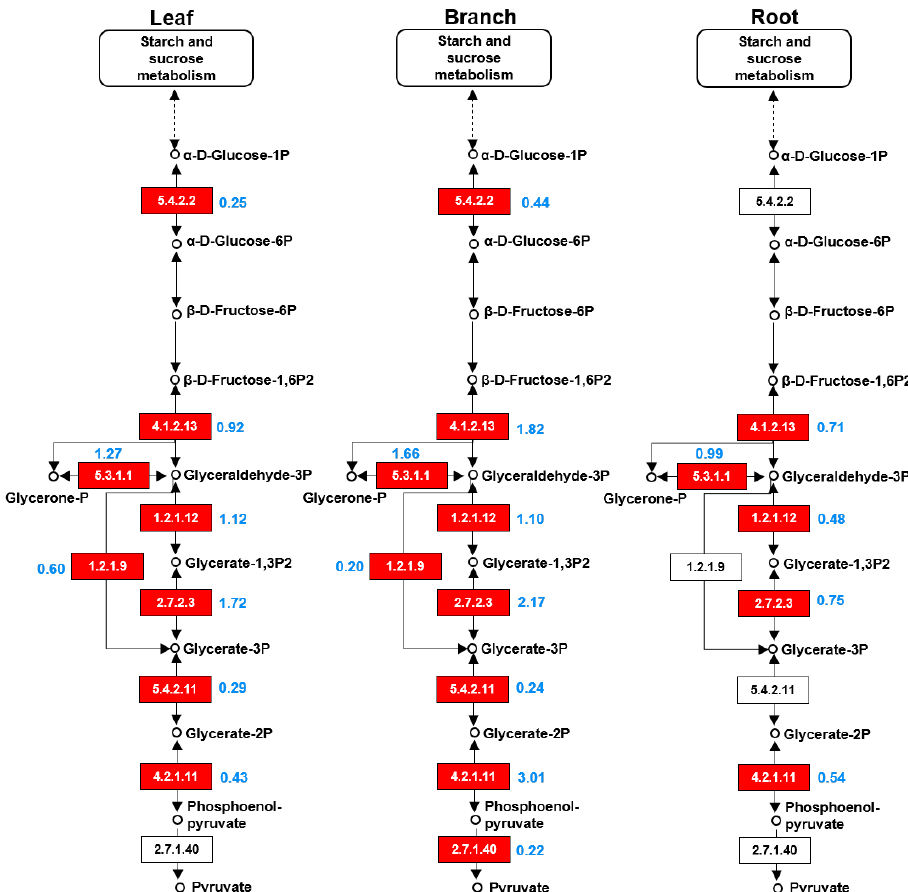
Figure 6. Mapping of proteins related to glycolysis in the three organs from Morus . The glycolysis pathways were identified by the mapping of the identified proteins from the leaf ( A ), branch ( B ), and root ( C ) using the KEGG database. Enzymes in red represent identified proteins, and the blue number represents the protein abundance. The EC number for the following proteins are 5.4.2.2, phosphoglucomutase; 4.1.2.13, fructose-bisphosphate aldolase; 5.3.1.1, triosephosphate